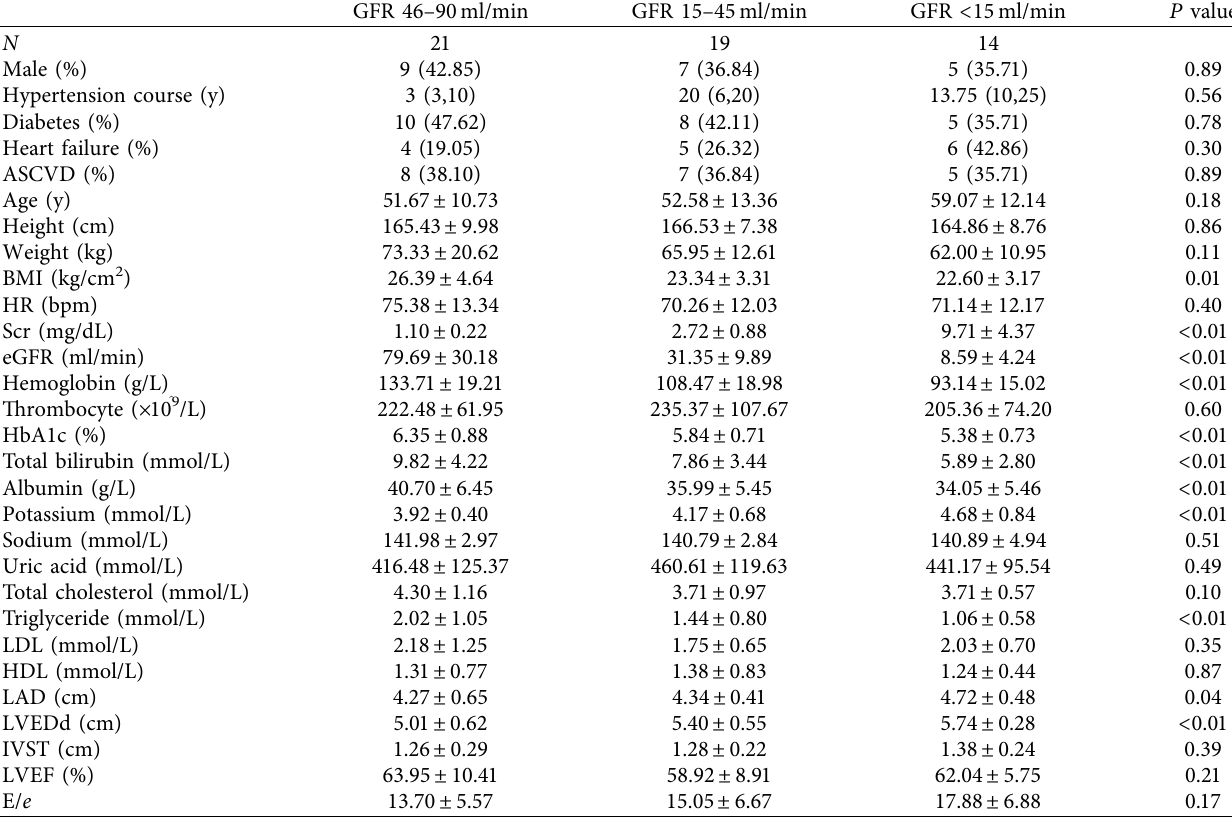
Table 1: Subjects and baseline